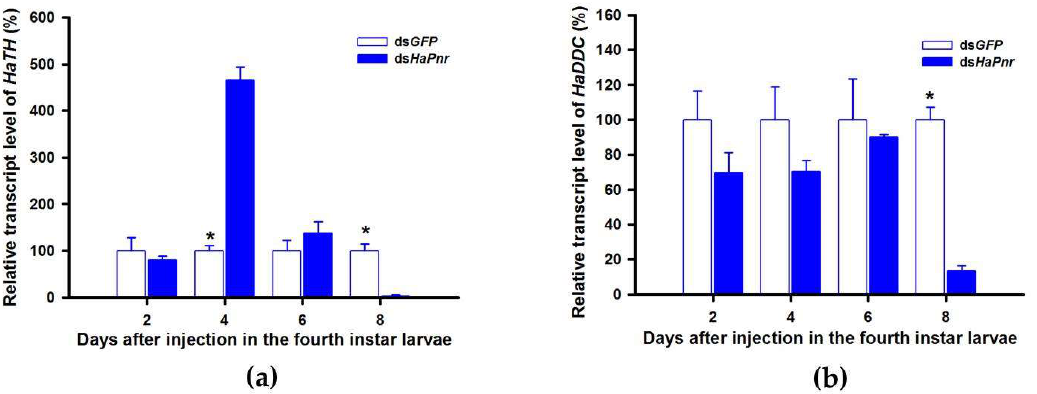
Figure 9. Relative transcript levels of HaTH ( a ) and HaDDC ( b ) following ds HaPnr injection in the fourth instar of H. axyridis . The results are presented as the mean and standard errors of three replicates; each was performed with a RNA sample prepared from three insects. Asterisk above the standard error bars indicate significant differences based on SPSS (v. 22, IBM Corp. Armonk, NY, USA) followed by One-Way ANOVA ( p < 0.05) within the same time point. “*” indicates a significant difference in relative transcript level of HaTH and HaDDC between insect injected with ds HaPnr and ds GFP .